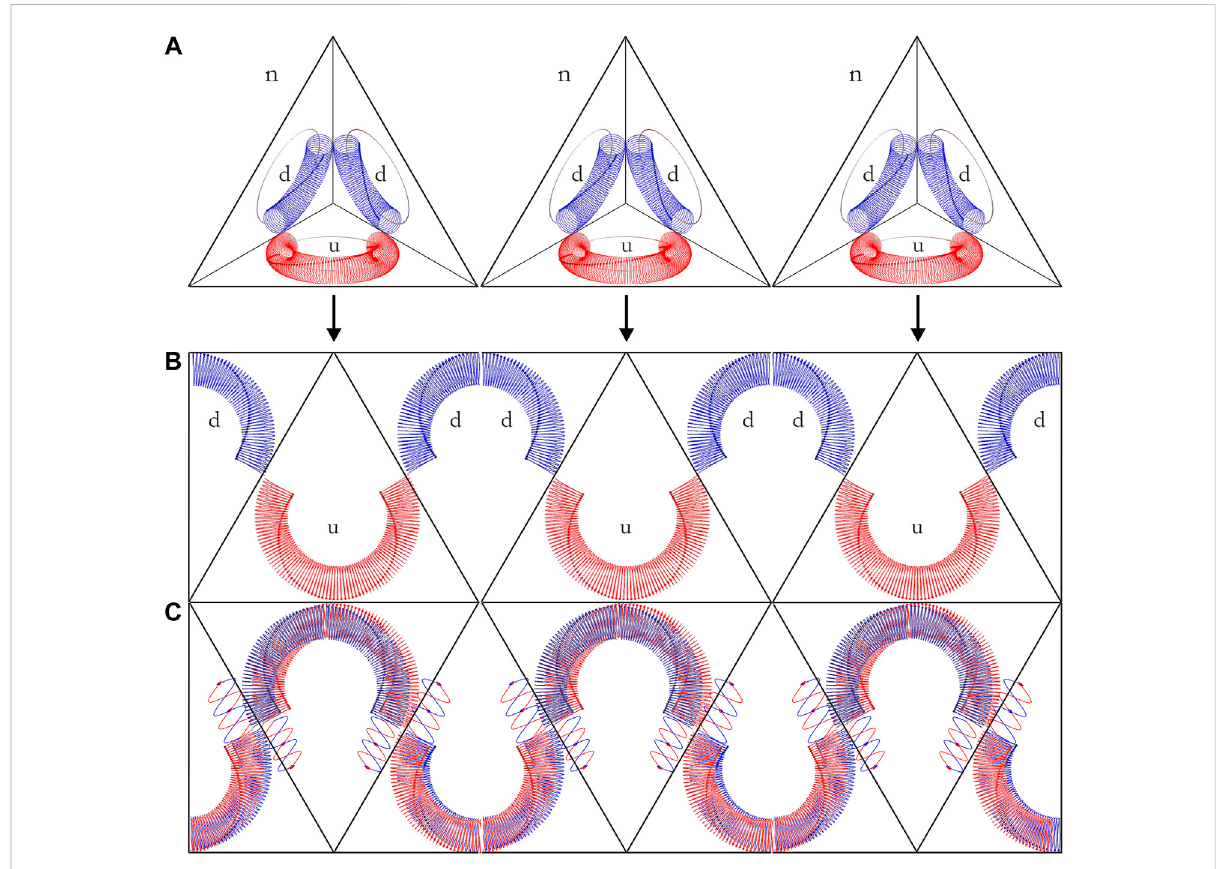
FIGURE 4 (A) When gravity outstrips the strong force in the black hole core, the tightly packed truncated-pyramid structures of neutrons (n) open and (B) fl attenintothelayersofquarks.Sincetheupquarks(u,red)andthedownquarks(d,blue)oftheadjacentlayersalignontopofeachother (C) ,thearcs of the tori with opposite handedness discharge, i.e., annihilate, into waves of paired quanta that jet out from above and below the planes where curvature, i.e., gravitation, is least (Illustrations by